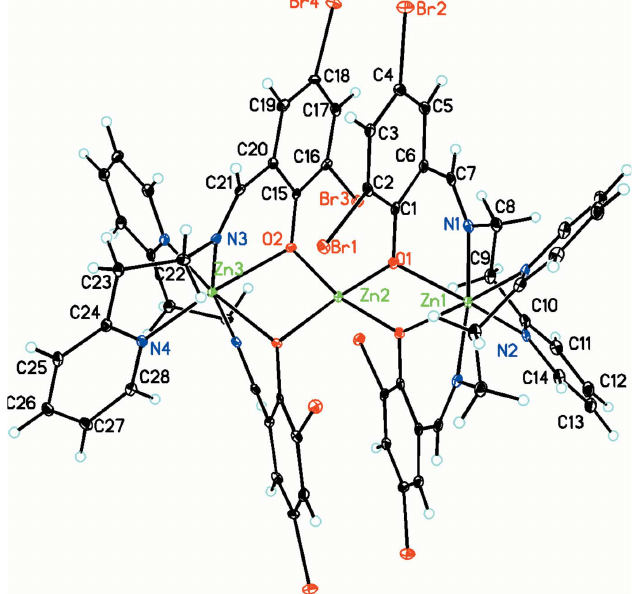
Figure 1 Diagram of the cation, tetrakis( (cid:3) 2 -( E )-2,4-dibromo-6-({[2-(pyridin-2- yl)ethyl]iminomethyl}phenolato)trizinc, showing the parallel dibromo- phenyl rings. Atomic displacement parameters are at the 30% probability